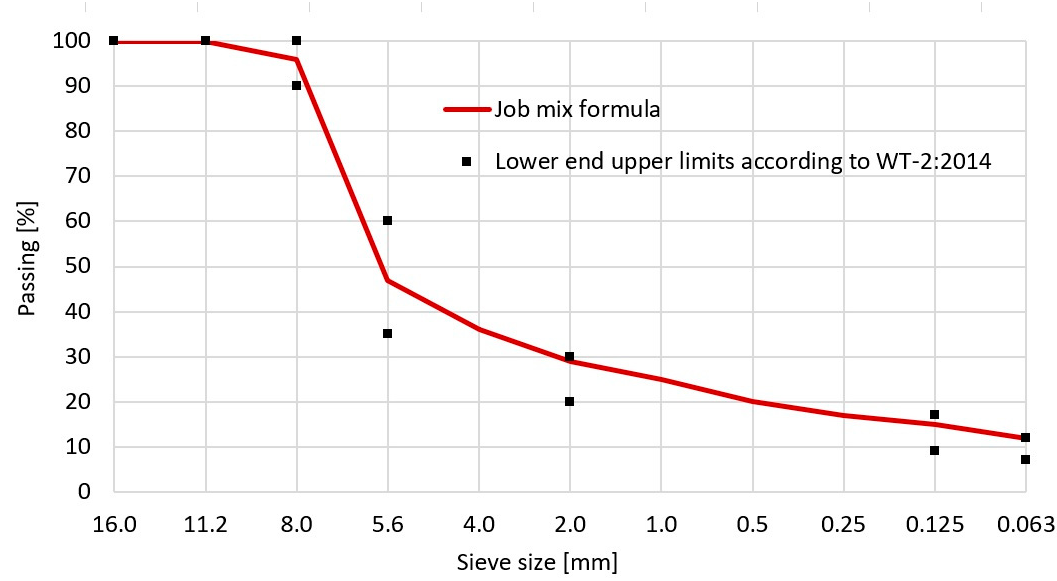
Figure 14. Gradation curve of SMA-MA 8 mixture.